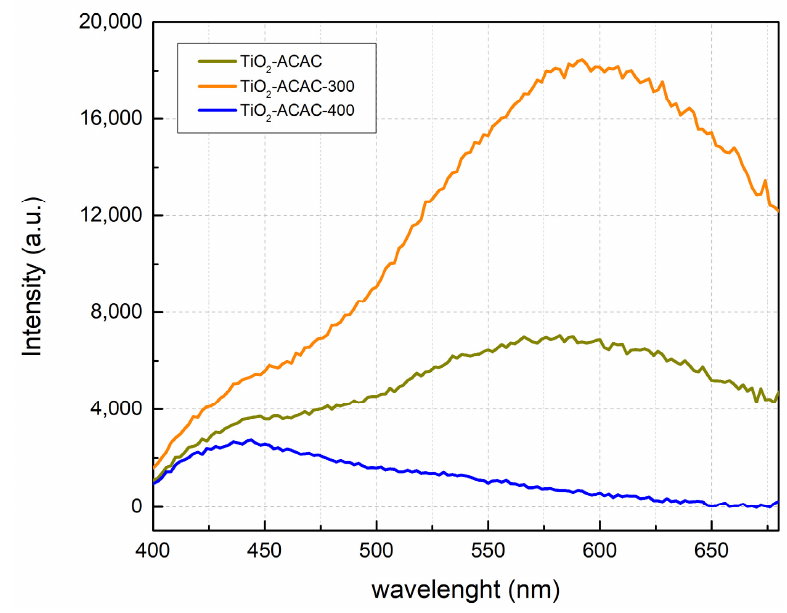
Figure 5. PL spectra of TiO 2 -ACAC, TiO 2 -ACAC-300 and TiO 2 -ACAC-400.